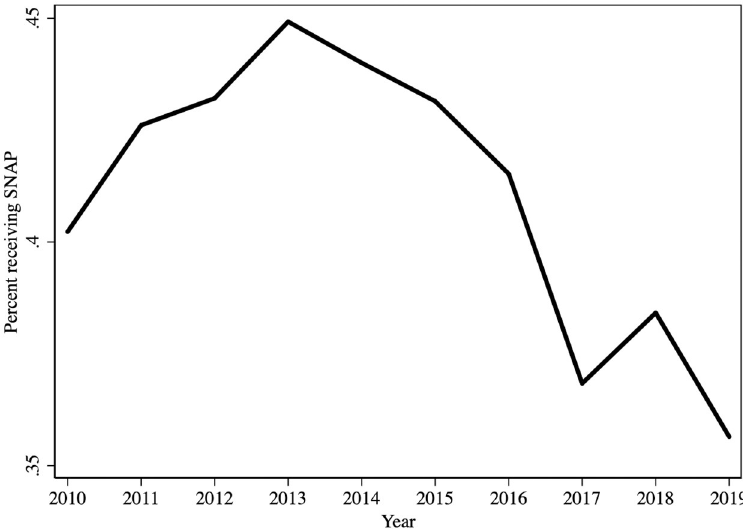
Fig 2. National trend in SNAP participation. Data source is the Current Population Survey ASEC, 2011–2020 (reporting periods 2010–2019). All 50 states and DC are